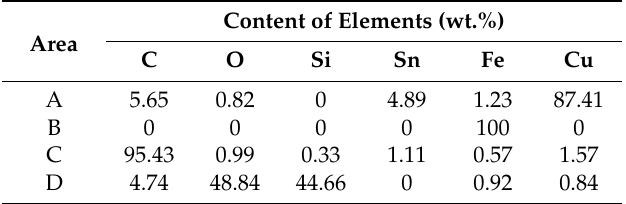
Table 3. EDS analysis results of area A, B, C, and D in Figure